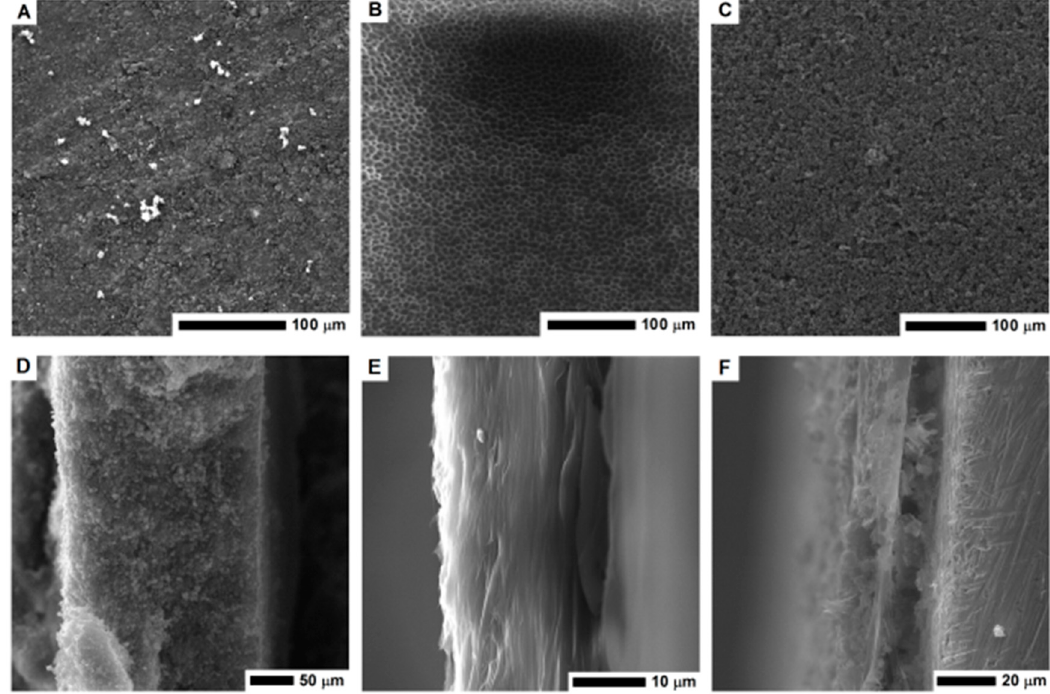
Figure 3. The SEM images of the surface area and cross-section of the MOF-5 pellet ( A , D ); PVDF layer ( B , E ) and nanocomposite of PVDF and carbonized MOF-5 ( C , F